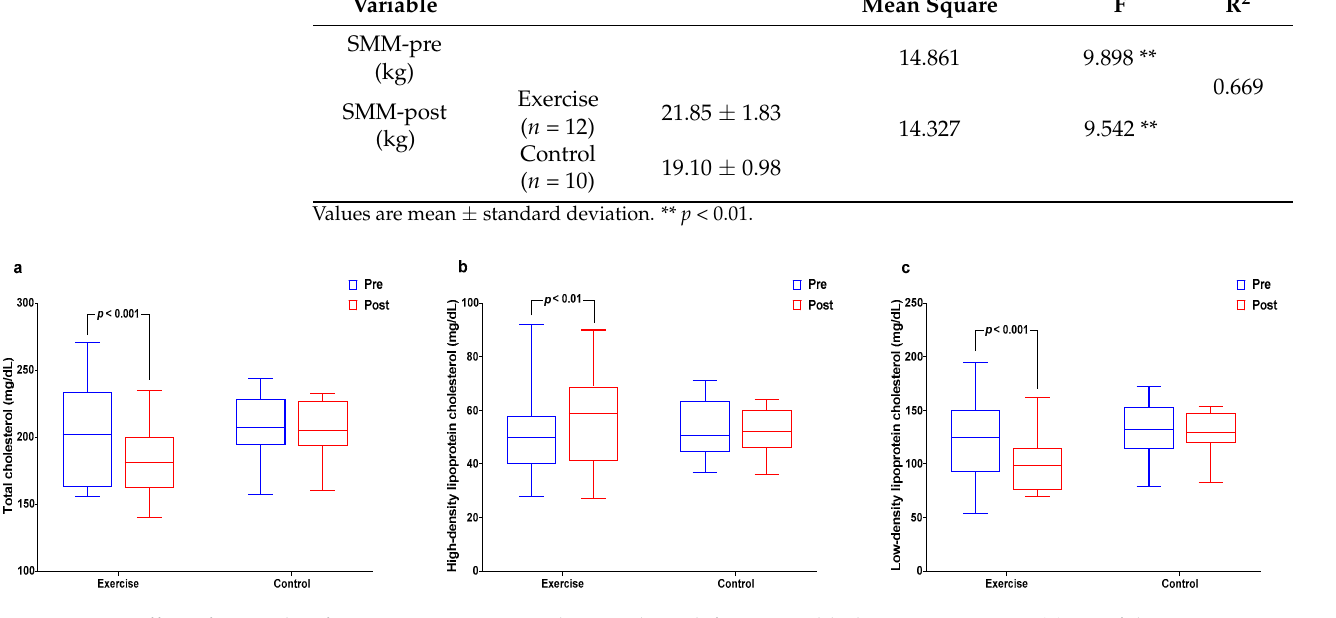
Figure 5. Effect of 12 weeks of aquatic exercise on aging-related sex hormones in elderly Korean women; ( a ) Testosterone of the control group was significantly decreased. ( p < 0.01); ( b ) DHEA-S showed significant interaction effects ( p < 0.05); ( c ) SHBG was significantly increased in the exercise group ( p < 0.01). SHBG: sex hormone-binding globulin. 3.6. Difference ( Δ ) in All Valuables after Aquatic Exercise Intervention Figure 6 shows difference in the change value of each of the variables. Briefly, Δ - SMM was found to be higher in exercise group ( p < 0.05) compared to control group. Δ - %BF and Δ -WC were found to be lower in exercise group ( p < 0.05) compared to control group. Δ -TC and Δ -LDL-C level were found to be lower in exercise group ( p < 0.01, p < 0.05) compared to control group. HDL-C level was found to be higher in exercise group ( p < 0.05) compared to control group. Δ -Glucose, Δ -Insulin and Δ -HOMA-IR level were found to be lower in exercise group ( p < 0.05) compared to control group. Δ -DHEA-S and Δ -SHBG level were found to be higher in exercise group ( p < 0.05, p < 0.01) compared to control group.